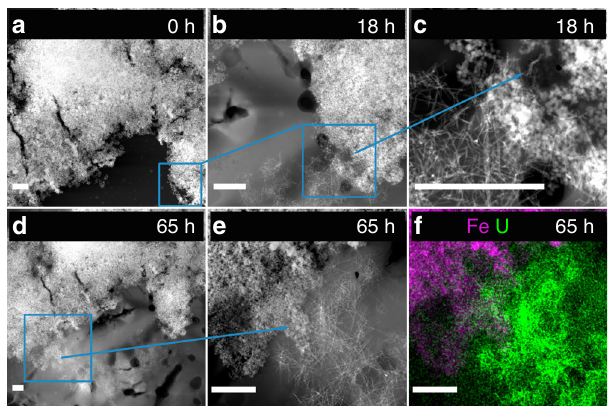
Fig. 6 Identical-location imaging of magnetite clusters. High-angle annular dark- fi eld scanning transmission electron microscopy (HAADF- STEM) images of identical magnetite clusters were collected (scale bar 500 nm). a At 0 h with only magnetite nanoparticles; b , c at 18 h showing the formation of U nanowires; the same region is indicated with blue boxes in a and b ; panel c represents the blue box in b ; d and e at 65 h show further expansion of the nanowires that now bridge the magnetite aggregate (arrow); panel e represents the region from the blue box in d ; panel f shows the STEM-EDS map of the region in e . The STEM-EDS maps of Fe and U con fi rm the formation of uranium nanowires after the magnetite cluster reacted in the U solution for 65 h.